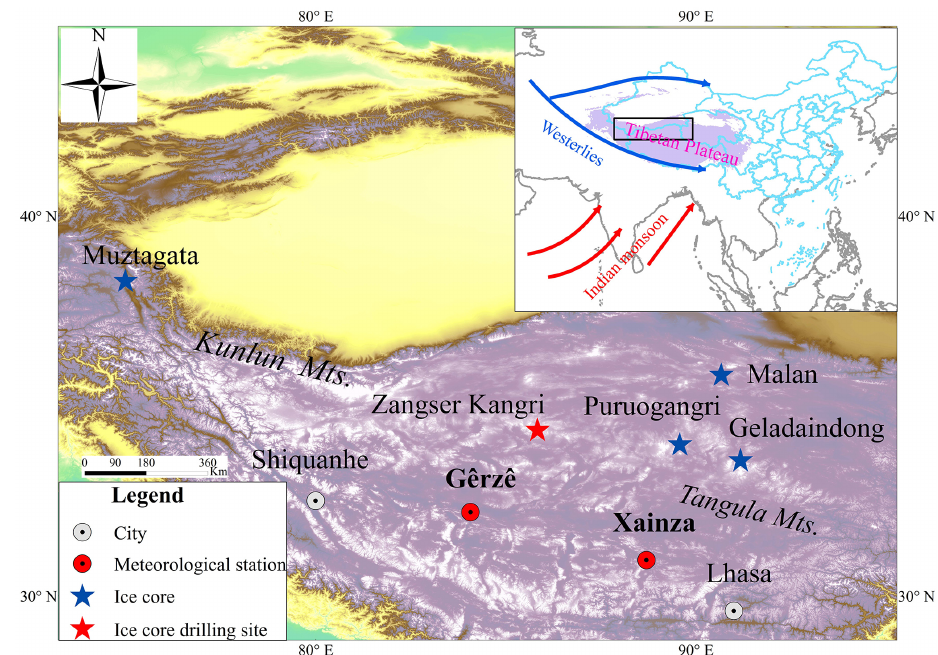
Figure 1. Location of the ice core drilling site of ZK, two nearby meteorological station sites, and the location of other ice cores described in the text: Muztagata (Tian et al., 2006), Puruogangri (Yao et al., 2006), Geladaindong (Kang et al., 2007), and Malan (Wang et al., 2003) over the northern TP. The inset shows the relative location of the northern TP to the entire TP. The black rectangle indicates the study area. Red and blue arrows represent the circulation patterns for the study region. Red arrows indicate the direction of the Indian monsoon (near surface) in summer, and blue arrows indicate the dominant westerlies (mid- to upper troposphere) in